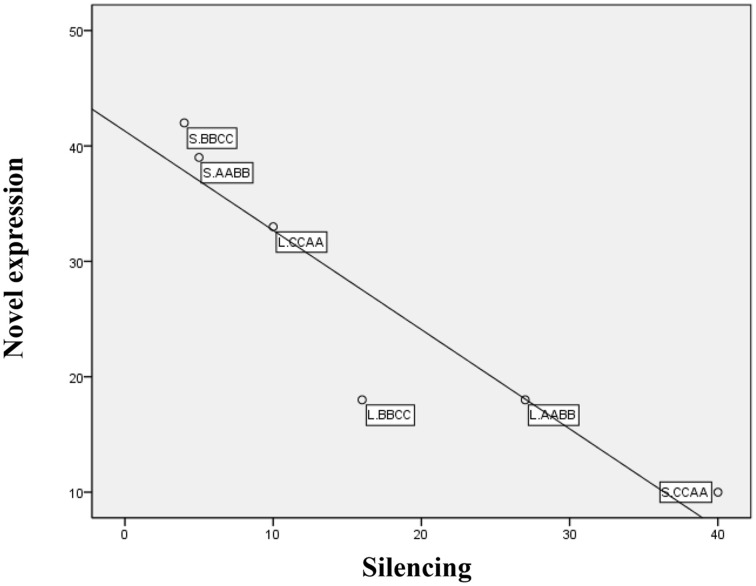
Inverse correlations between number of genes for novel expression and silencing among samples.